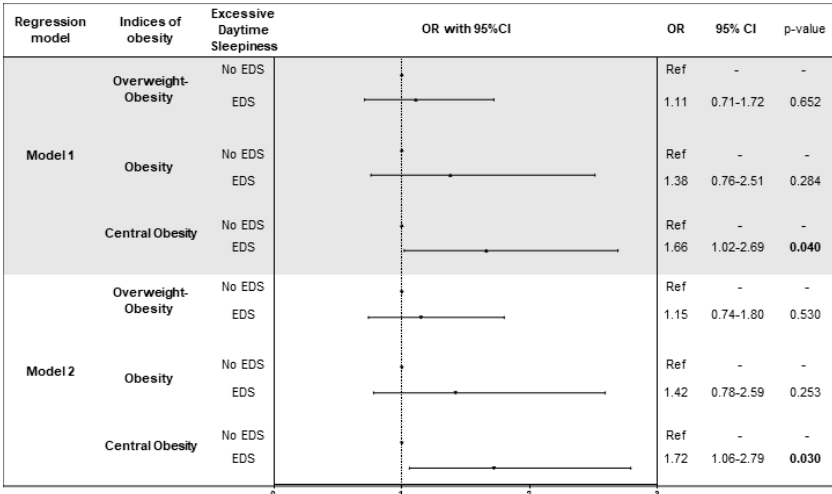
Figure 2. Logistic regression models of the association between excessive daytime sleepiness and indices of obesity. Model 1 was adjusted for age, sex, smoking status, marital status, employment, risk of sleep apnoea, medical history and treatments (diabetes, hypertension and hyperlipidaemia). Model 2 was adjusted for age, sex, smoking status, marital status, employment, medical history and treatments (diabetes, hypertension and hyperlipidaemia), diet, total energy intake and physical activity.